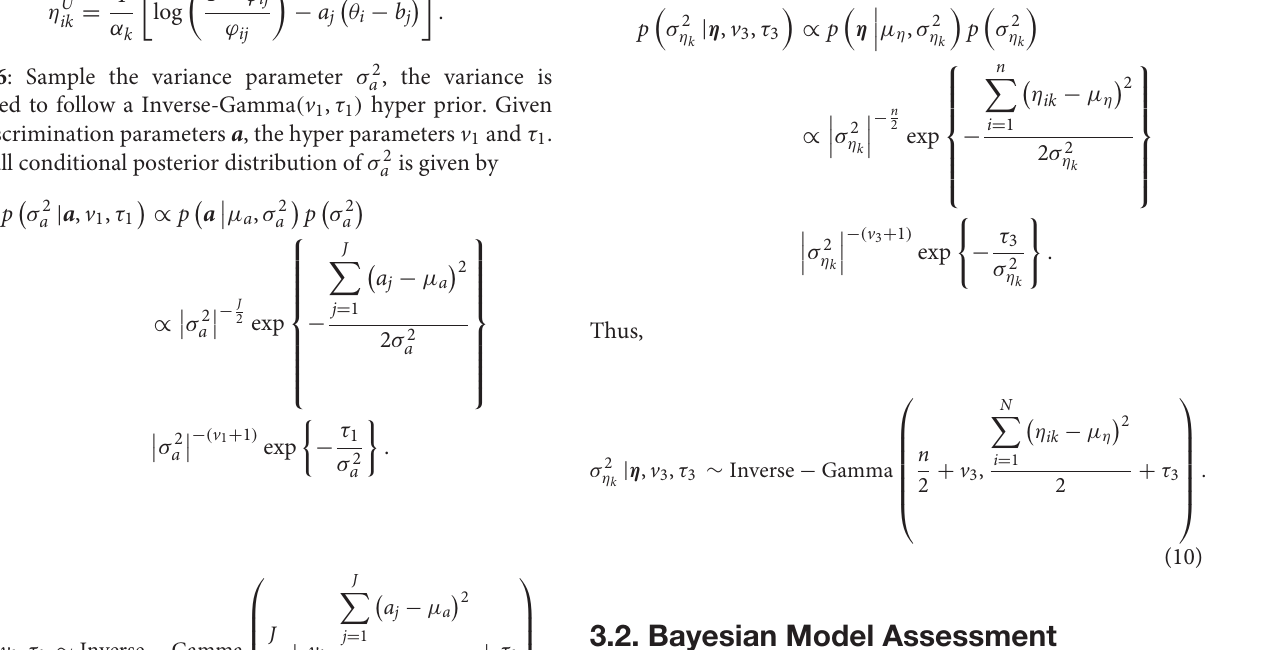
Step 8 : Sample the random effect variance parameter σ 2 η